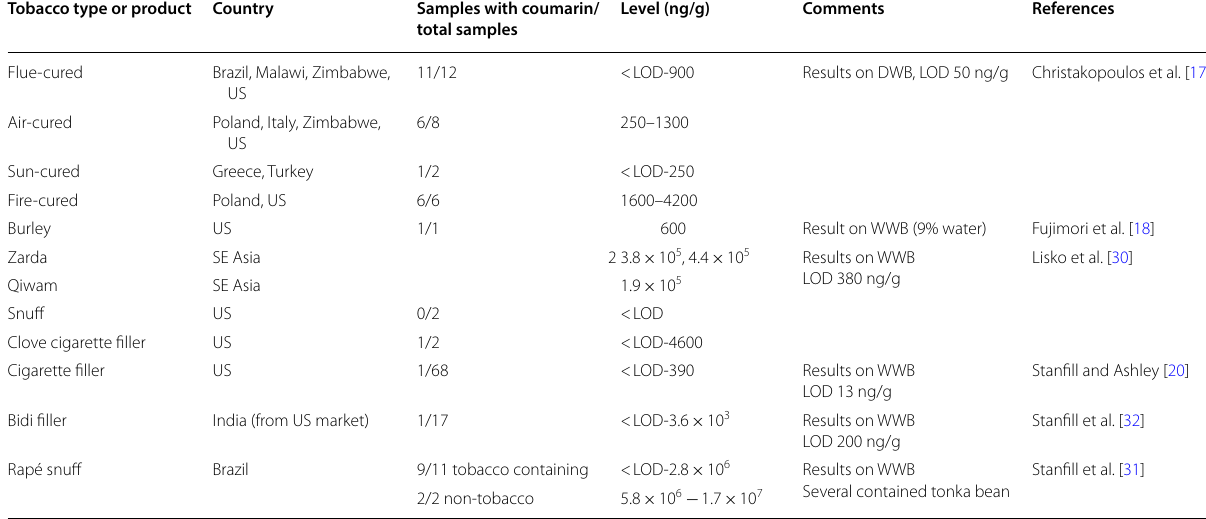
Table 3 Levels of coumarin in tobacco and tobacco products Tobacco type or product